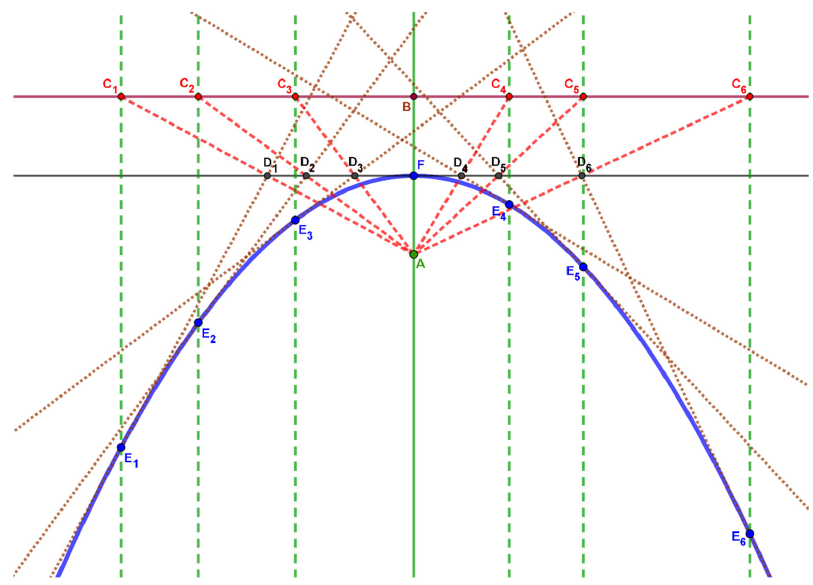
Figure 5. Mydorge’s pointwise construction of the parabola (Proposition II 19).